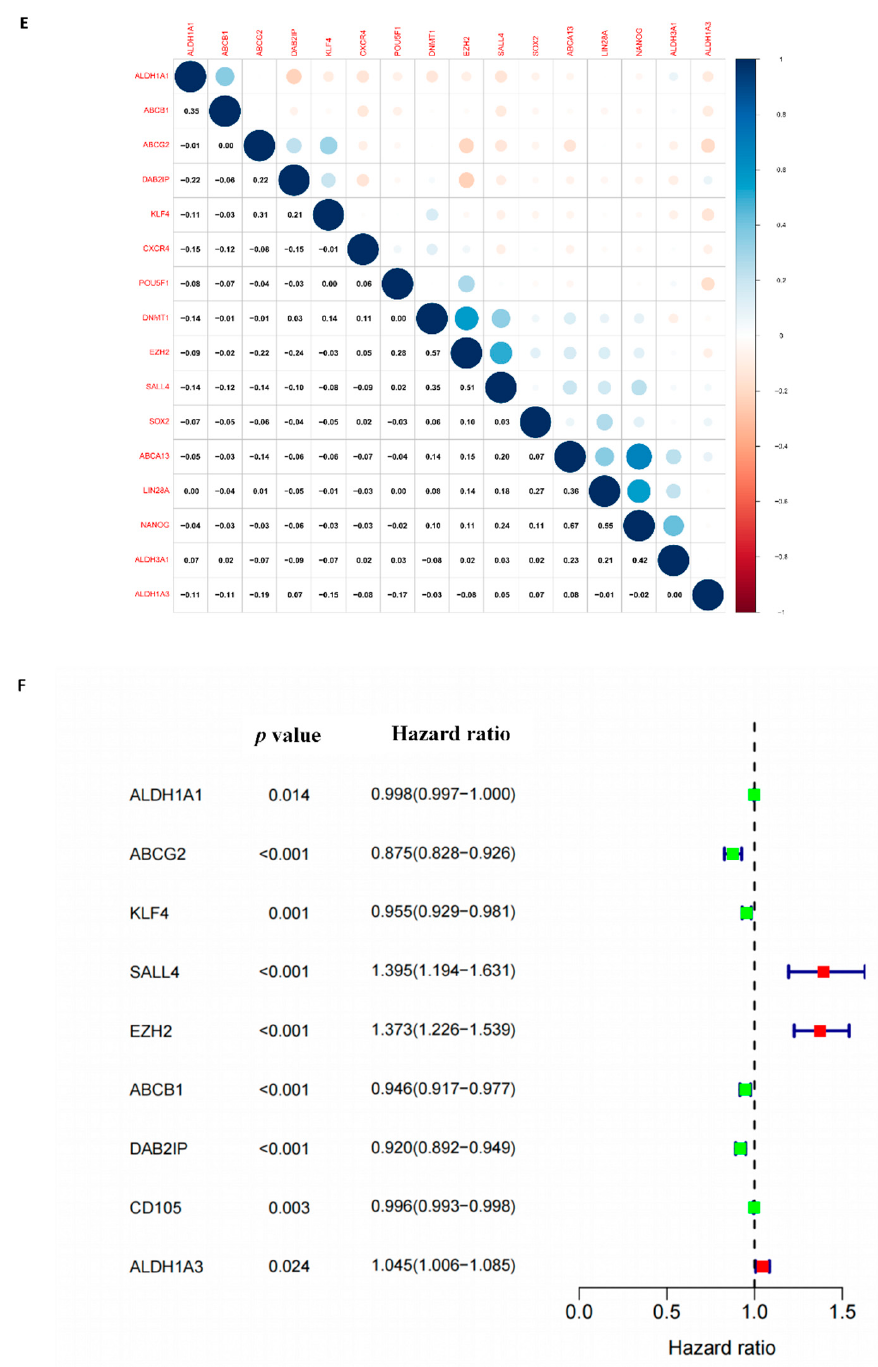
Figure 2. The expression analysis of potential CSC markers in the KIRC tissue and associated normal tissue and univariate COX regression analysis: ( A ) mRNAsi and ( B ) corrected-mRNAsi and association with clinical characteristics in KIRC patients; ( C ) mRNA expression of 19 potential CSC markers, blue indicates normal tissue, and red indicates KIRC tumor tissue; ( D ) heatmap of the expression level of potential CSC markers; ( E ) correlation plot among the expression levels of potential CSC markers based on the Pearson correlation test ( p < 0.05 indicates statistical significance); * p < 0.05, ** p < 0.01, *** p < 0.001, **** p < 0.0001. ( F ) univariate COX regression analysis with OS-related CSC markers, significant markers with p < 0.005 are listed.